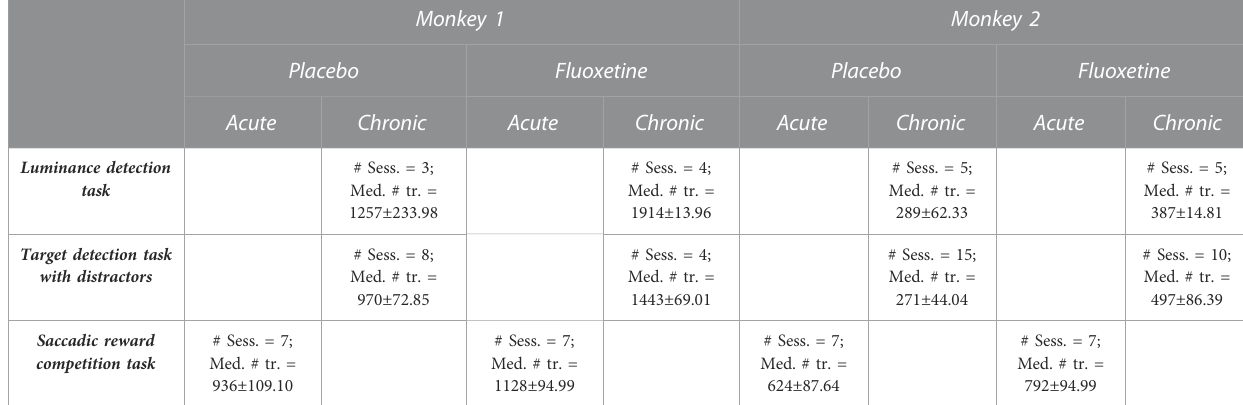
TABLE 1 Description of number of sessions and trial statistics. Number of sessions and trial statistics (median +se) are described per type of tasks (luminance detection task, target detection task with distractors and saccadic reward competition task), condition (placebo and fl uoxetine) and monkeys. Injections for the saccadic reward competition task, were performed acutely (1 day per week). For the other tasks, injections were performed according to a chronic injection